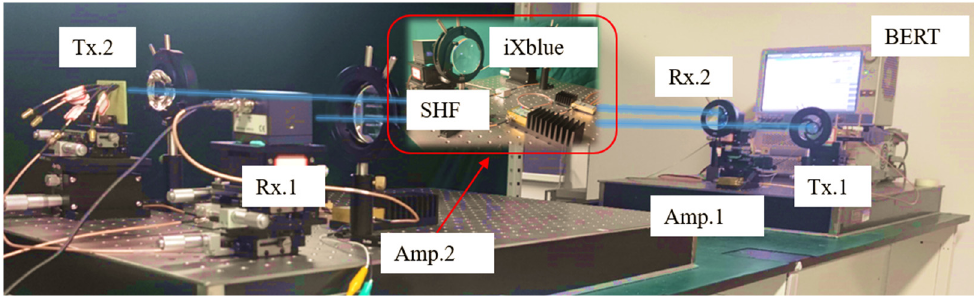
Figure 2. Experimental setup of dual-hop VLC lin k . (Inset: Cascade Amp.2.)